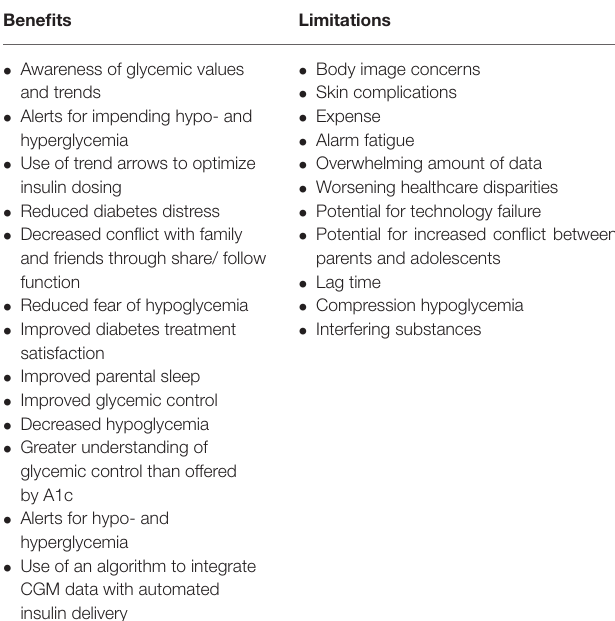
TABLE 9 | Benefits and limitations of continuous glucose